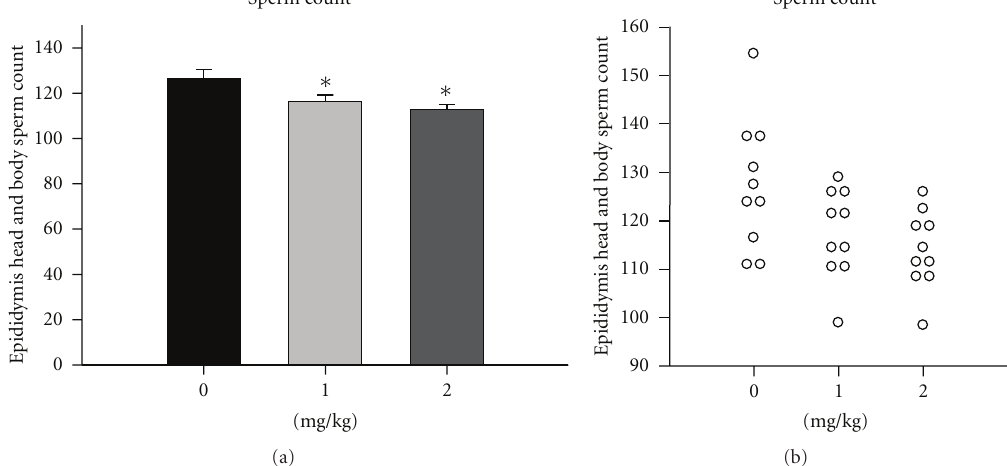
Figure 6: (a) Sperm count of the epididymis head and body at necropsy for each HgCl 2 exposure group. (b) Distribution of the epididymis head and body sperm count at necropsy for each exposure group. Data are mean and SE, ∗ : a significant di ff erence from the control group ( P < 0 . 05). Scale on “ y -axis” di ff ers for each chart to give better representation of